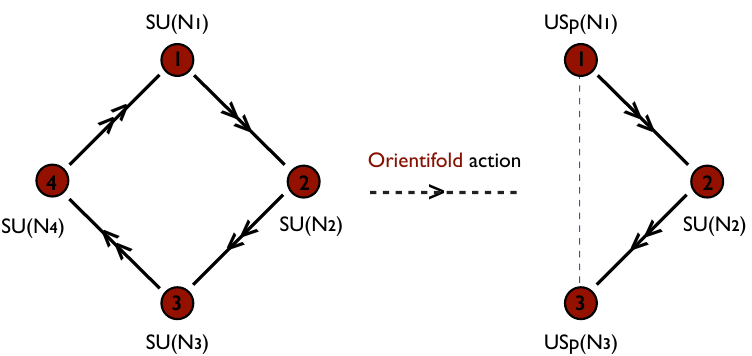
Figure 1 . Quiver diagram of F F 0 on the left and of 0 = (cid:10) on the right. The light blue line represents the (cid:12)xed locus under the orientifold action and corresponds to a O7-plane. In our conventions USp( N ) = Sp( N= 2), with N even. In this way, at each node, be it SU or USp, N is the number of D- branes in the parent theory. Note that N 1 = N 3 and N 2 = N 4 , in order to cancel gauge anomalies. 1 =N corrections due to the orientifold and read